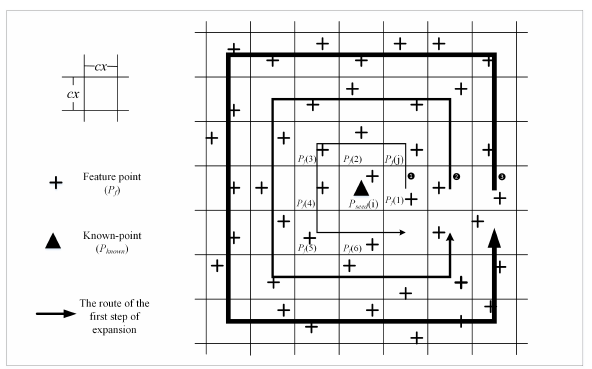
Figure 3. First step of expansion. The size of the route indicates a different iteration. For example, the expansion route no.1 is used at the first time of iteration, the expansion route no.2 at the second, and so on. The known point in the figure happens to be a seed point and is therefore represented by a triangle.